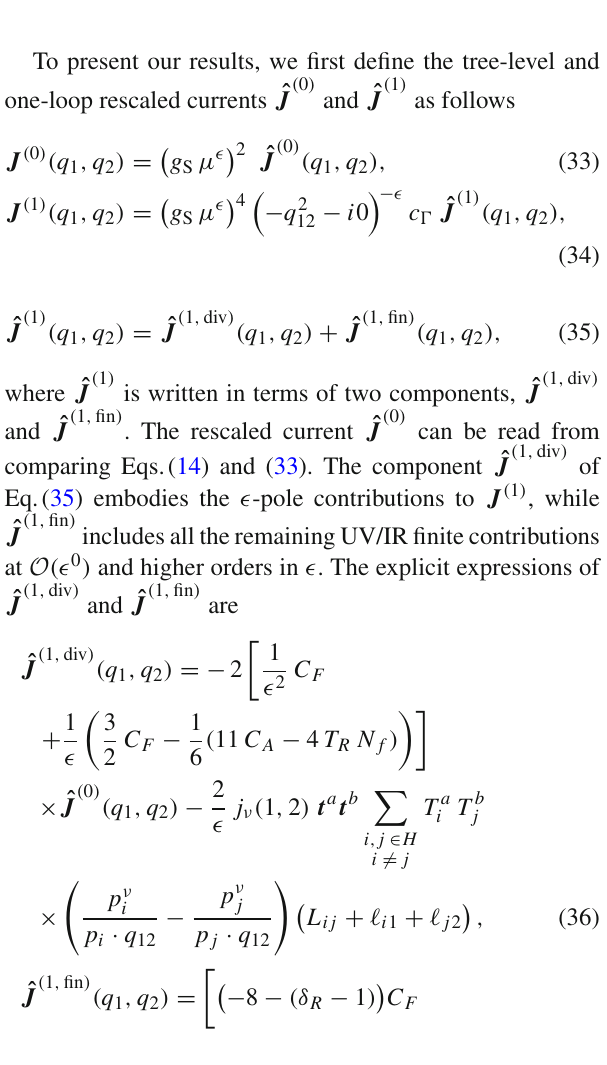
Fig. 1 Example of two one-loop Feynman diagrams that contribute to the one-loop current J ( 1 ) for soft q ¯ q emission. The external-leg hard partons with momenta p i and p j are coupled to virtual gluons by using the eikonal approximation. The dashed line symbolically denotes the colour indices and momenta of the additional external legs. The effect of the tree-level scattering amplitude M ( 0 ) ( p 1 ,..., p n ) (see Eq.(8)) is given by an effective pointlike vertex (little black circle) that only depends on the colour structure of M ( 0 ) (on the colour indices of the hard